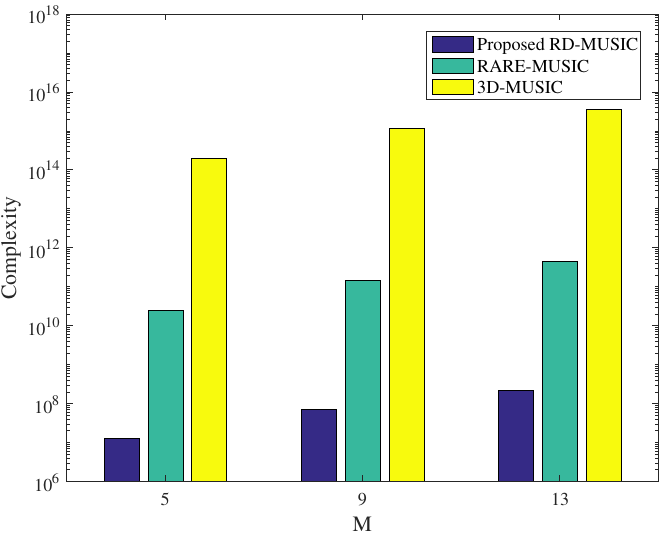
Figure 2. Comparison of the complexity of